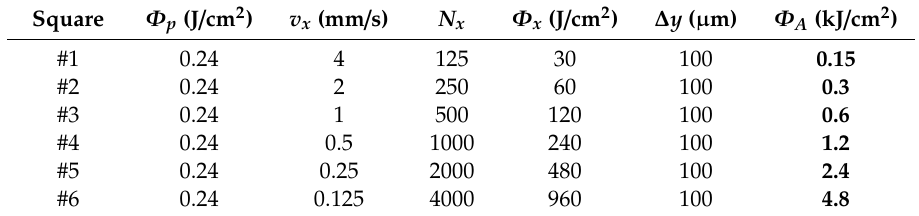
Table 1. Experimental parameters of the six di ff erent laser treatments performed on the screen-printed carbon